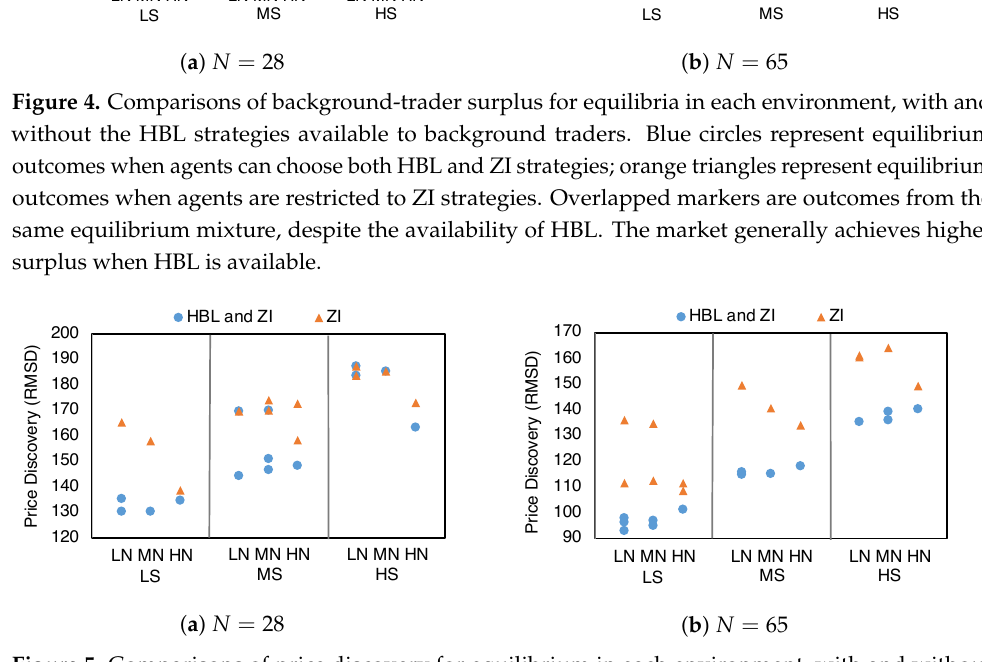
Figure 5. Comparisons of price discovery for equilibrium in each environment, with and without the HBL strategies available to background traders. Blue circles represent equilibrium outcomes when agents can choose both HBL and ZI strategies; orange triangles represent equilibrium outcomes when agents are restricted to ZI strategies. Overlapped markers are outcomes where the equilibrium mixture is ZI only, despite the availability of HBL. The market generally achieves better price discovery when HBL is